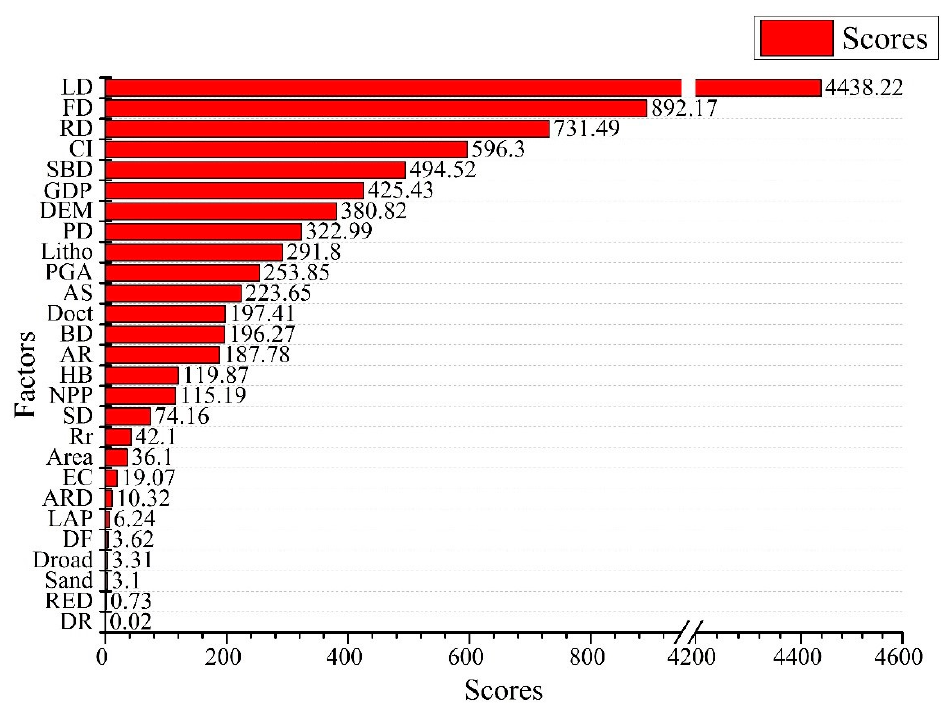
Figure 16. Ranking of the importance of influencing factors.